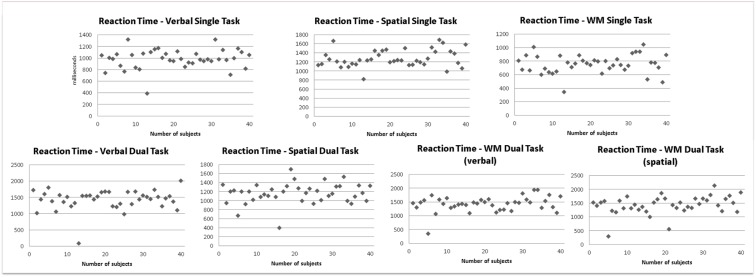
Reaction times for all single-tasks and dual-tasks.The scatter plots show the actual data of all 38 participants for visual verification of the distribution.